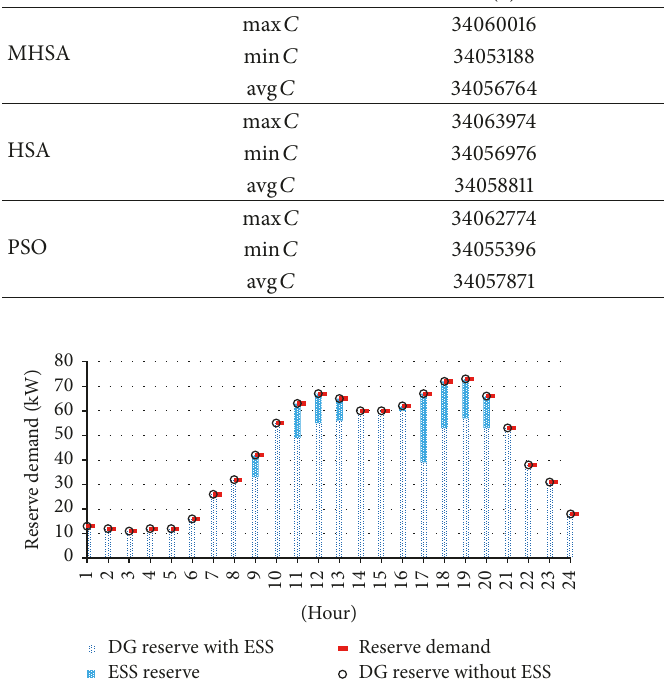
Table 4: Comparison of optimal installation and related costs predicted by the MHSA, HSA, and PSO in Case 1. Algorithm